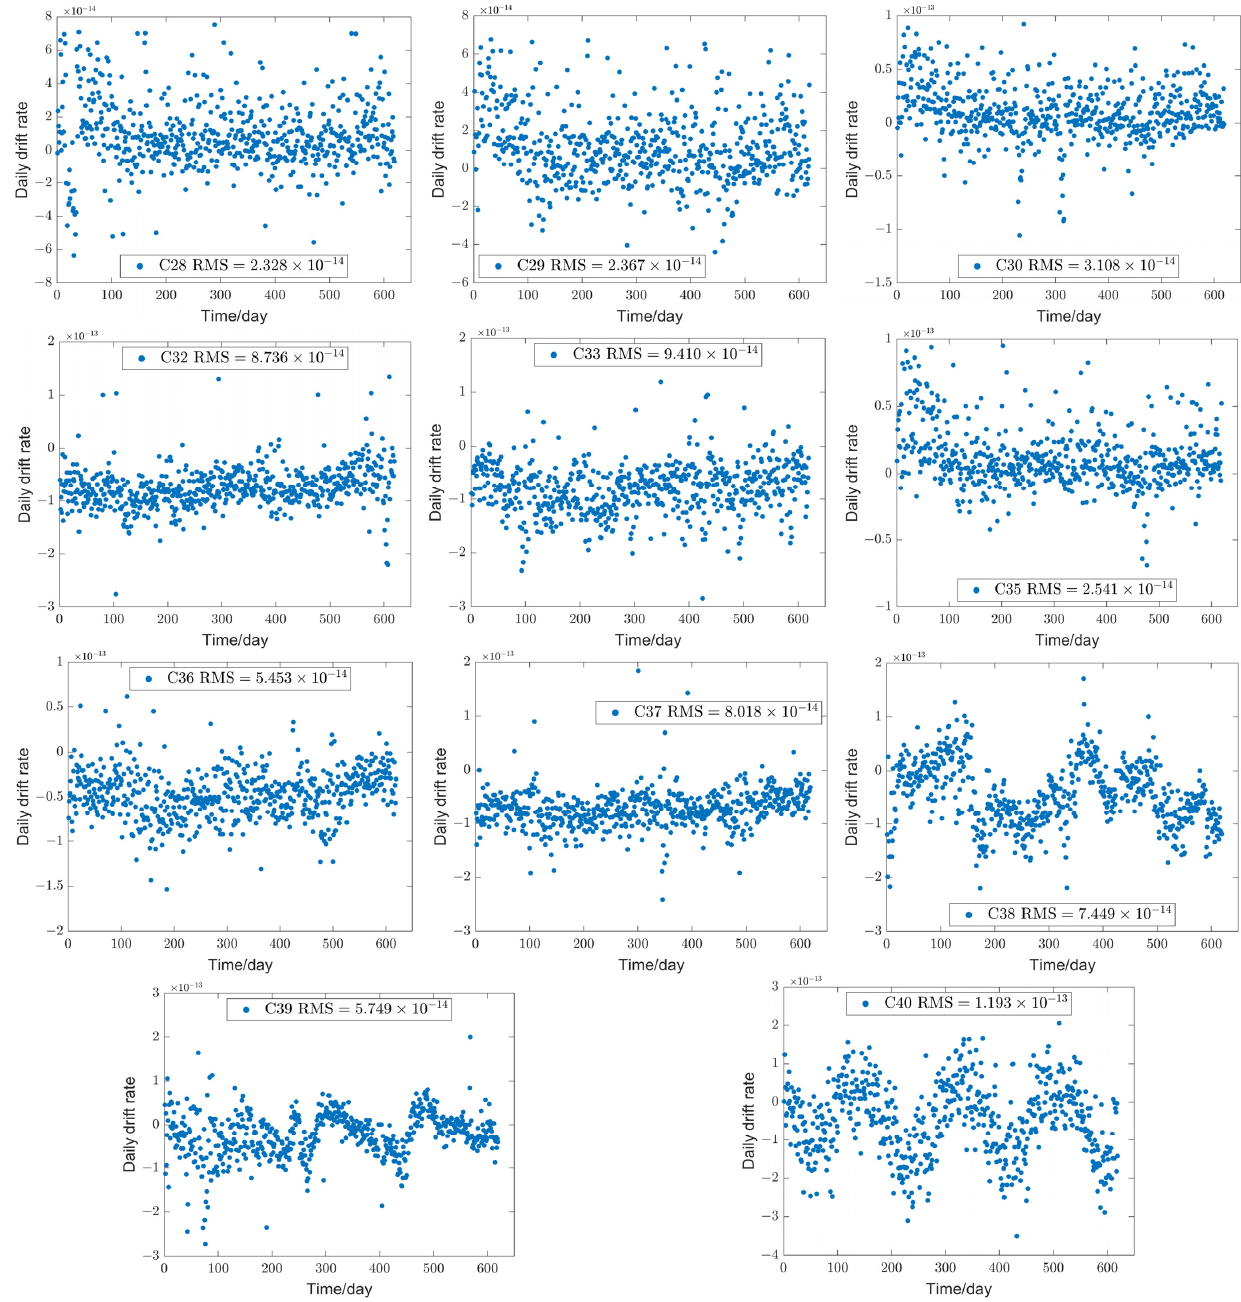
Figure 8. Daily drift rate of BDS satellite clocks.